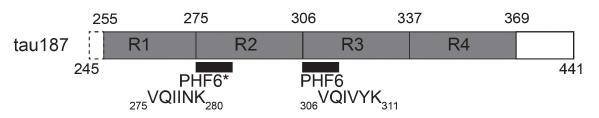
FIGURE 1 | Schematic of tau187. It contains all four repeat domains R1-R4, minus 10 residues of R1, and the C-terminus. The N-terminal end contains a six histidine tag for purification (not